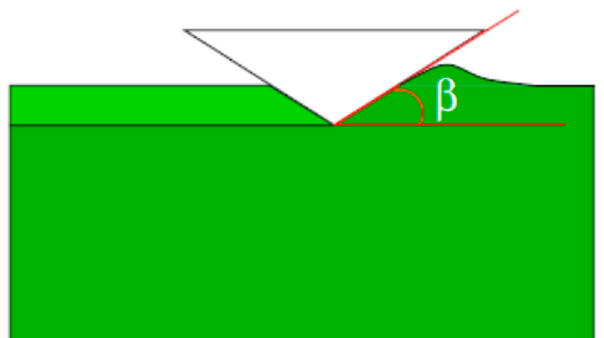
Figure 2. Schematic of the scratching problem. The angle β defines the geometry of the conical stylus where presently β = 22°. The scratch direction is from left to right.